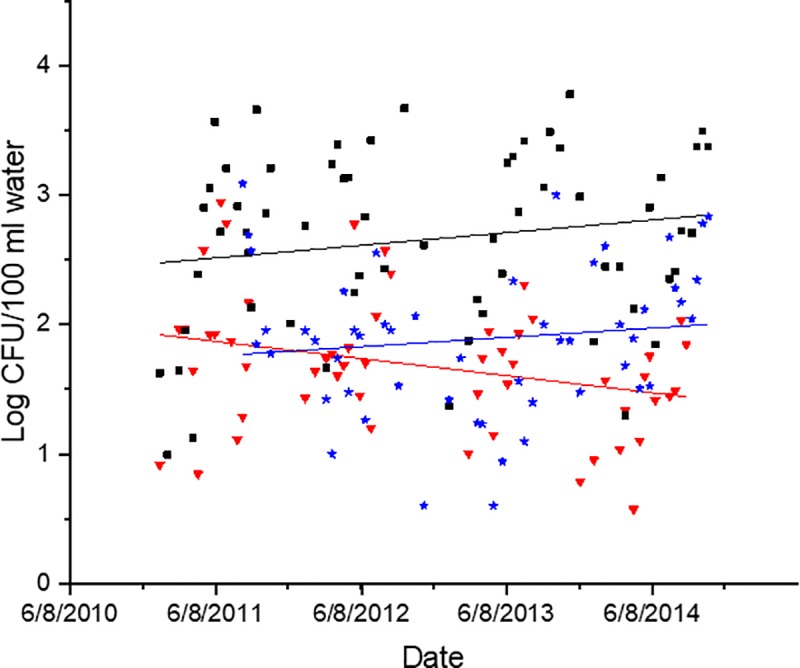
Vibrio spp. (black squares), V. vulnificus (red triangles), and V. parahaemolyticus (blue stars) concentrations at each sampling date for the last four years of study at station 70S.Lines are the linear regression of the data for V. vulnificus (red line, r2 = 0.1, p<0.05), V. parahaemolyticus (blue line, p>0.05) and Vibrio spp. (black line, p>0.05). Non-detectable samples were removed from this analysis.